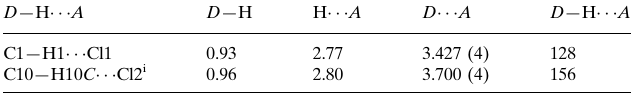
Hydrogen-bond geometry (A˚ , (cid:2)